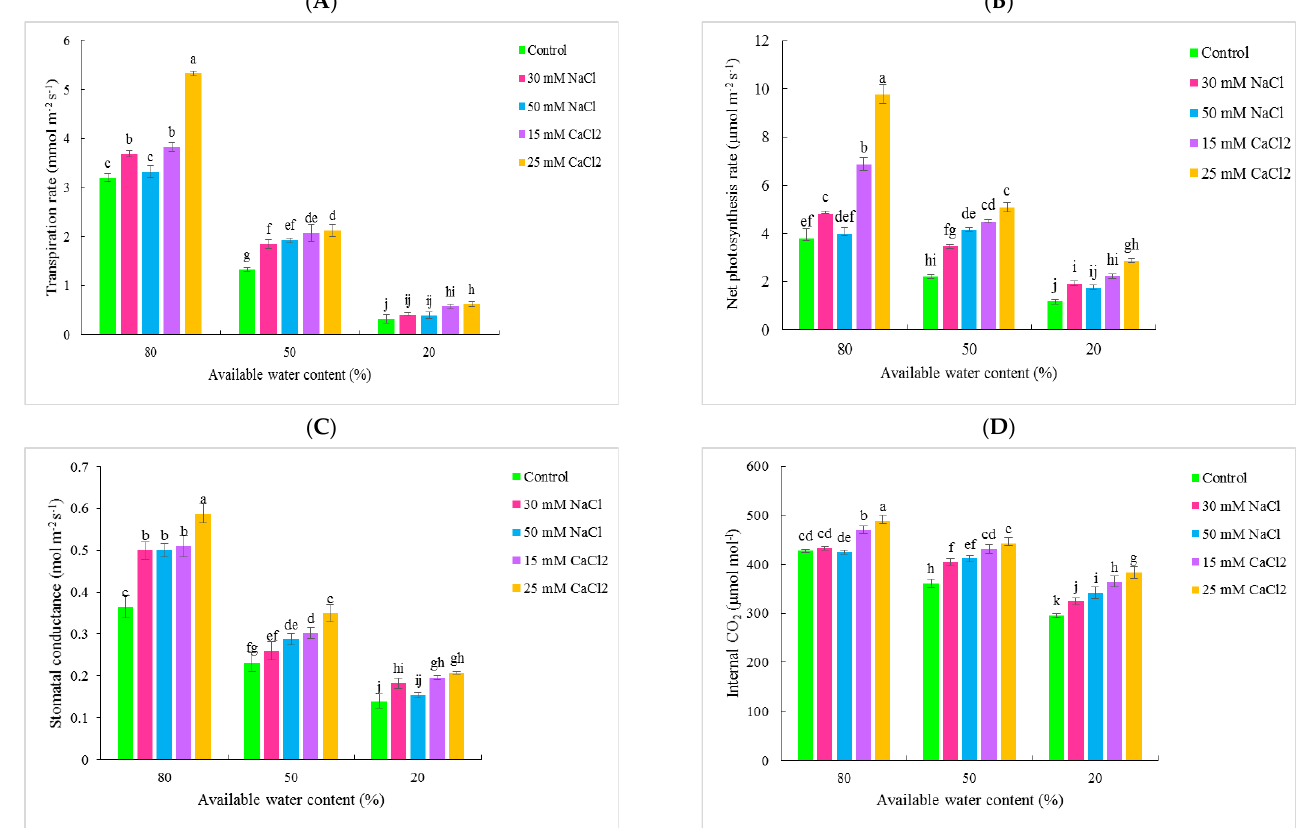
Figure 1. Transpiration ( A ), photosynthesis ( B ), stomatal conductance ( C ) and internal CO 2 concentration ( D ) of periwinkle cv. ‘Pacifica XP Really Red’ plants initially receiving NaCl (0, 30 and 50 mM) or CaCl 2 (15 and 25 mM) via irrigation (five applications at 3 d intervals), and subsequently exposed to different watering levels (80, 50 and 20% available water content) during cultivation. At first application, plants were at the four-leaf stage. Values with different letters indicate significant differences ( p = 0.05; comparison in columns). Values are the mean of four replications.